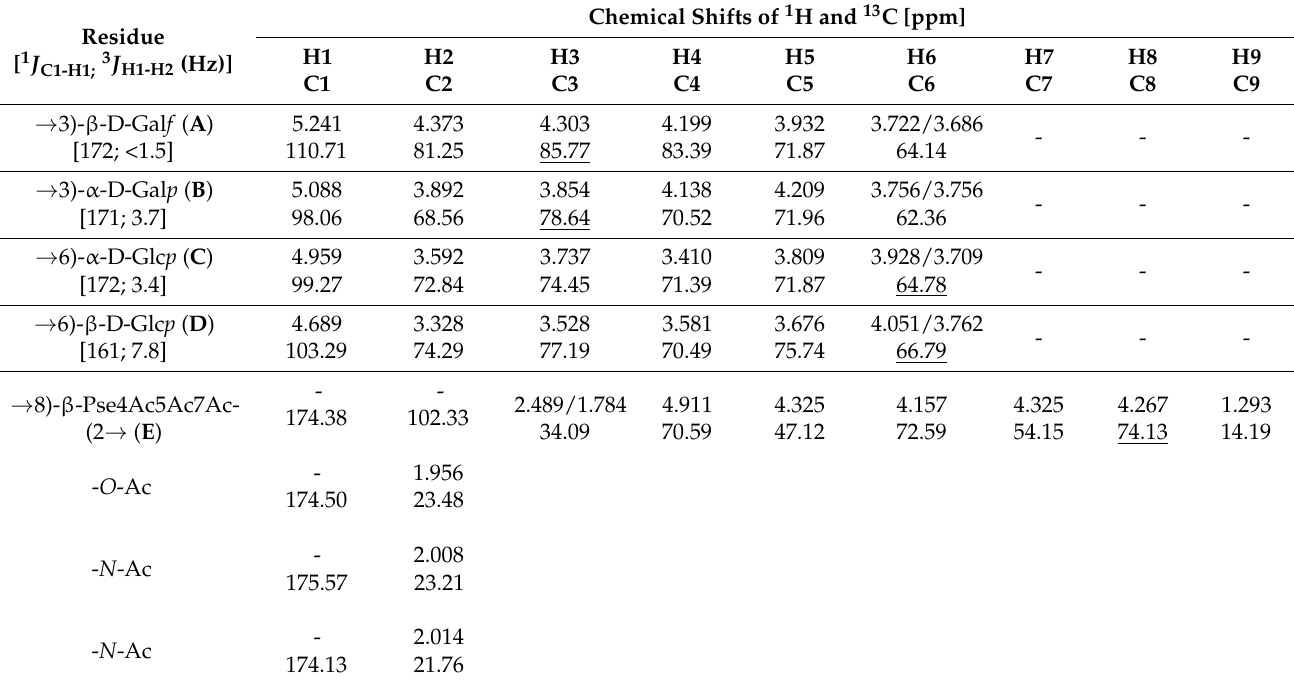
Table 1. 1 H and 13 C NMR data of the OPS isolated from P. parmentieri SCC3193. The glycosylated carbon atoms are